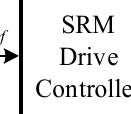
equations presented in Section 2.3, and input DC voltage 40 V, DC output voltage 200 V,